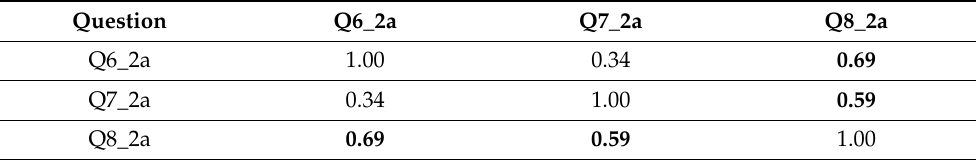
Table 3. Spearman rank correlation coefficients for questions 6_2a, 7_2a, and 8_2a.